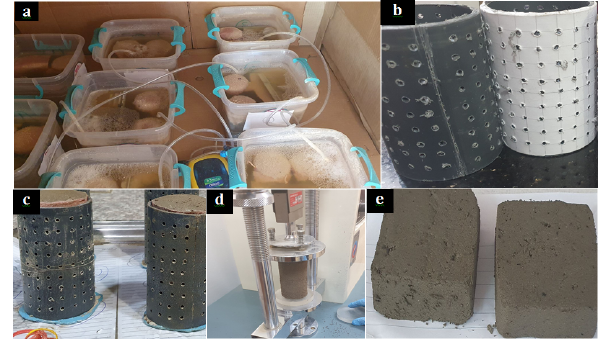
Figure 1: Photograph of the (a) Treatment system, (b, c, e) molds and samples, (d) UCS test